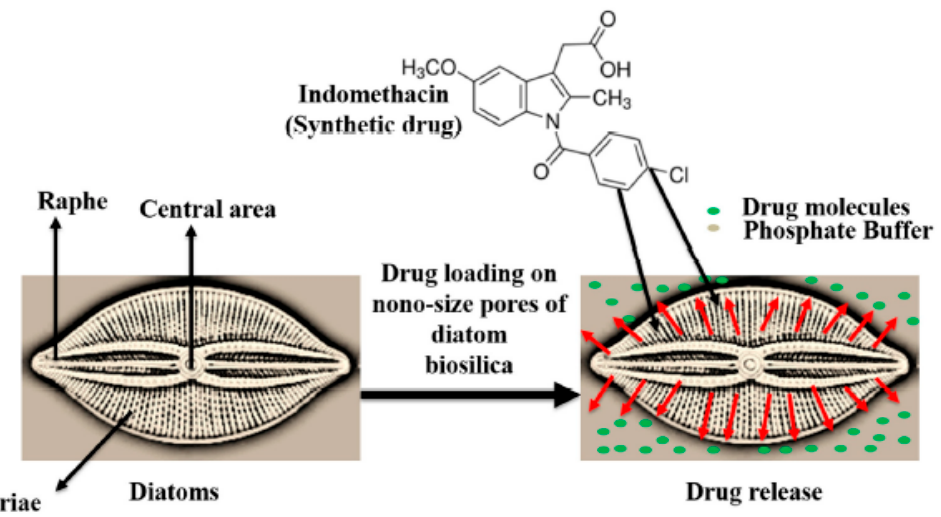
Figure 2. The mechanism of drug release from the porous diatom microshell [2].